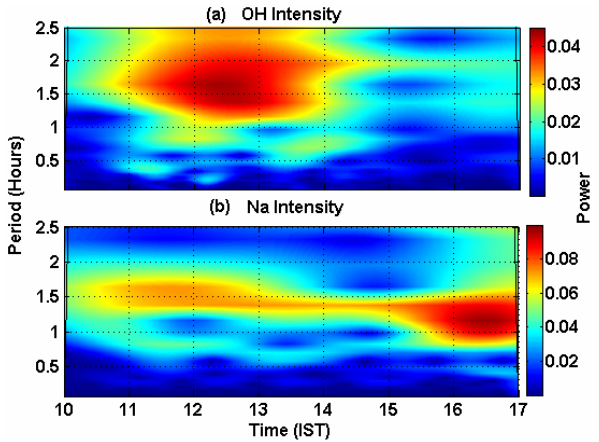
Fig. 6. Wavelet periodograms of (a) OH Intensity and (b) Na Inten- sity, on 19 February